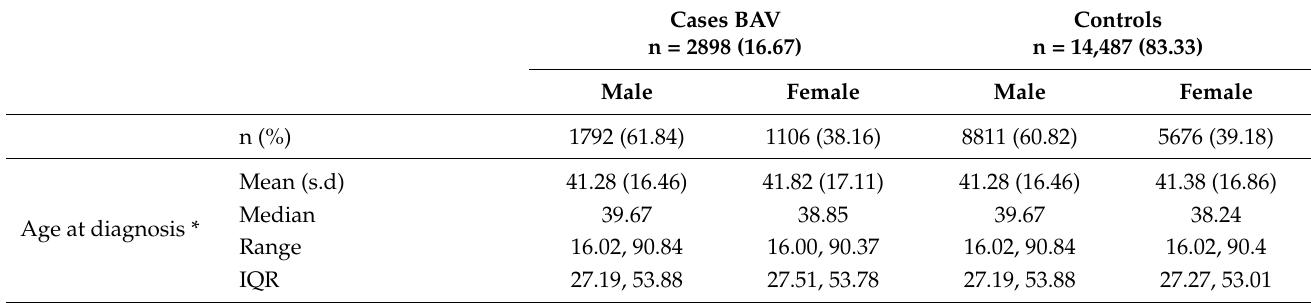
Table 1. Characteristics of case and controls by gender.